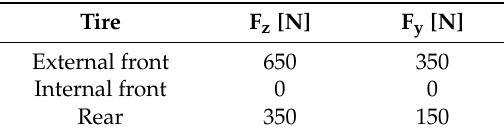
Table 2. Rollover